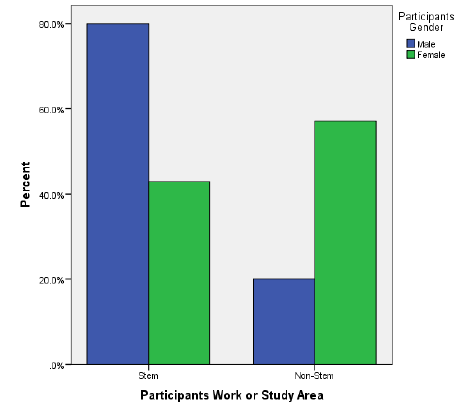
Figure 6. STEM and Non-STEM Gender.